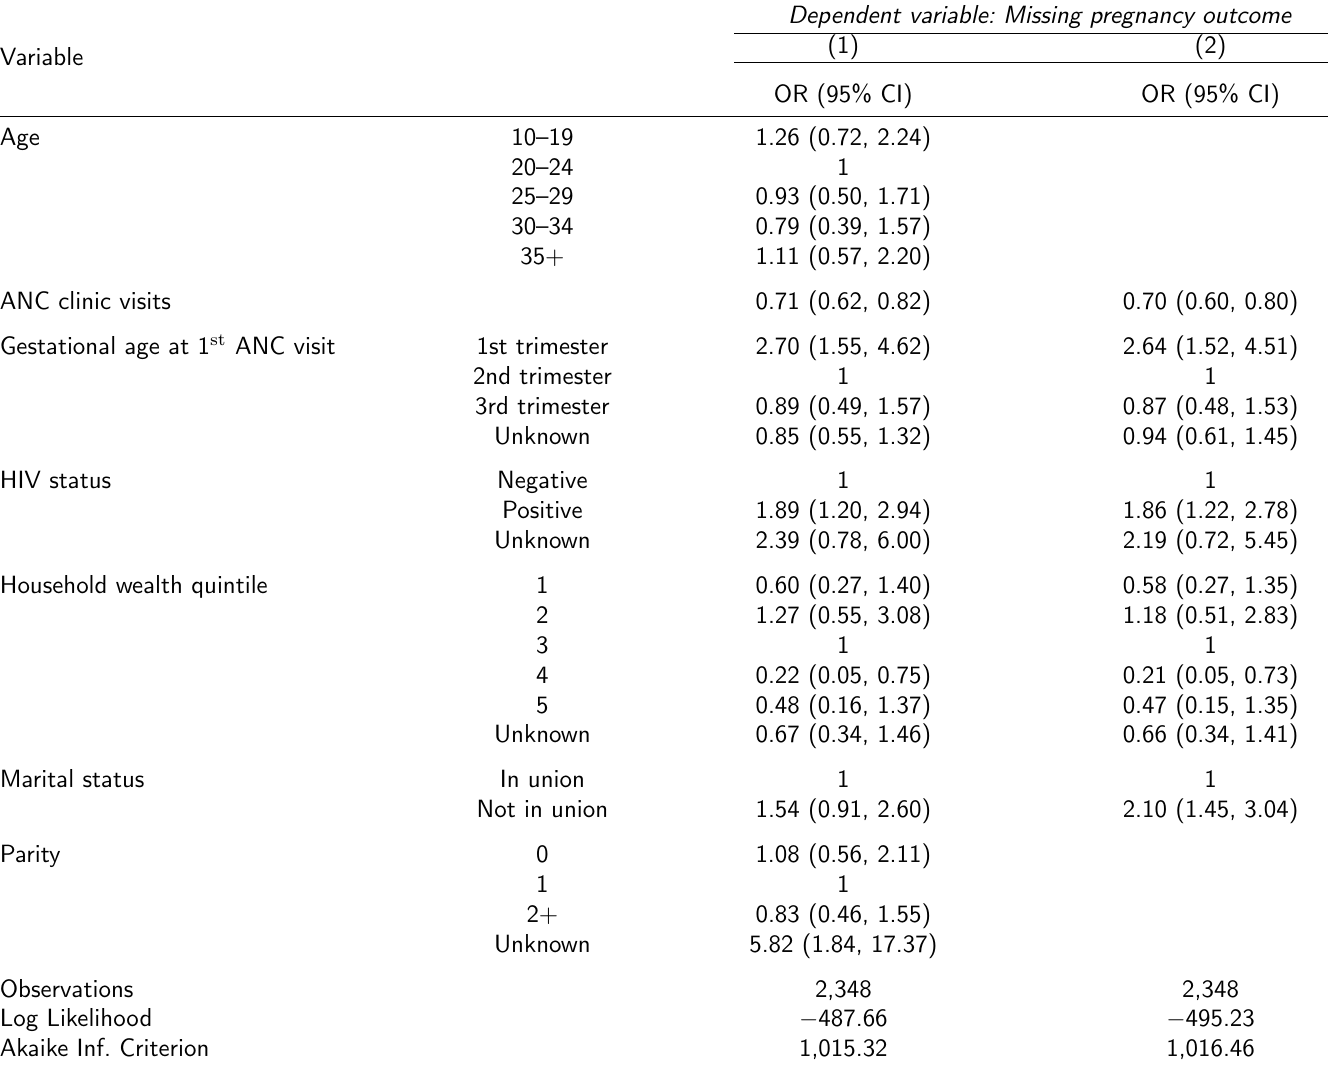
Table 3: Logistic regression results for having a missing pregnancy outcome in the HDSS Dependent variable: Missing pregnancy